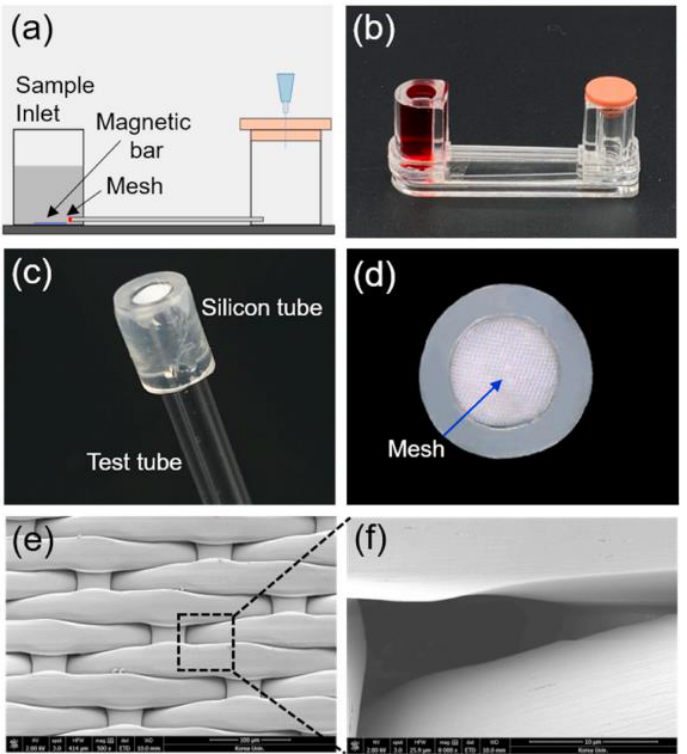
Figure 1. ( a ) An experimental illustration of a COVID-19 detection microfluidic chip. ( b ) Three-dimensional (3D) photograph of the experimental apparatus. ( c ) 3D photograph of a flexible silicon tube bonded to the nylon mesh and glass tube. ( d ) Front view of the attached nylon mesh with silicon tubing to prevent leaks. ( e ) SEM image of the nylon mesh. ( f ) SEM image of a single micro-hole of the nylon mesh. Reprinted with permission from [18].